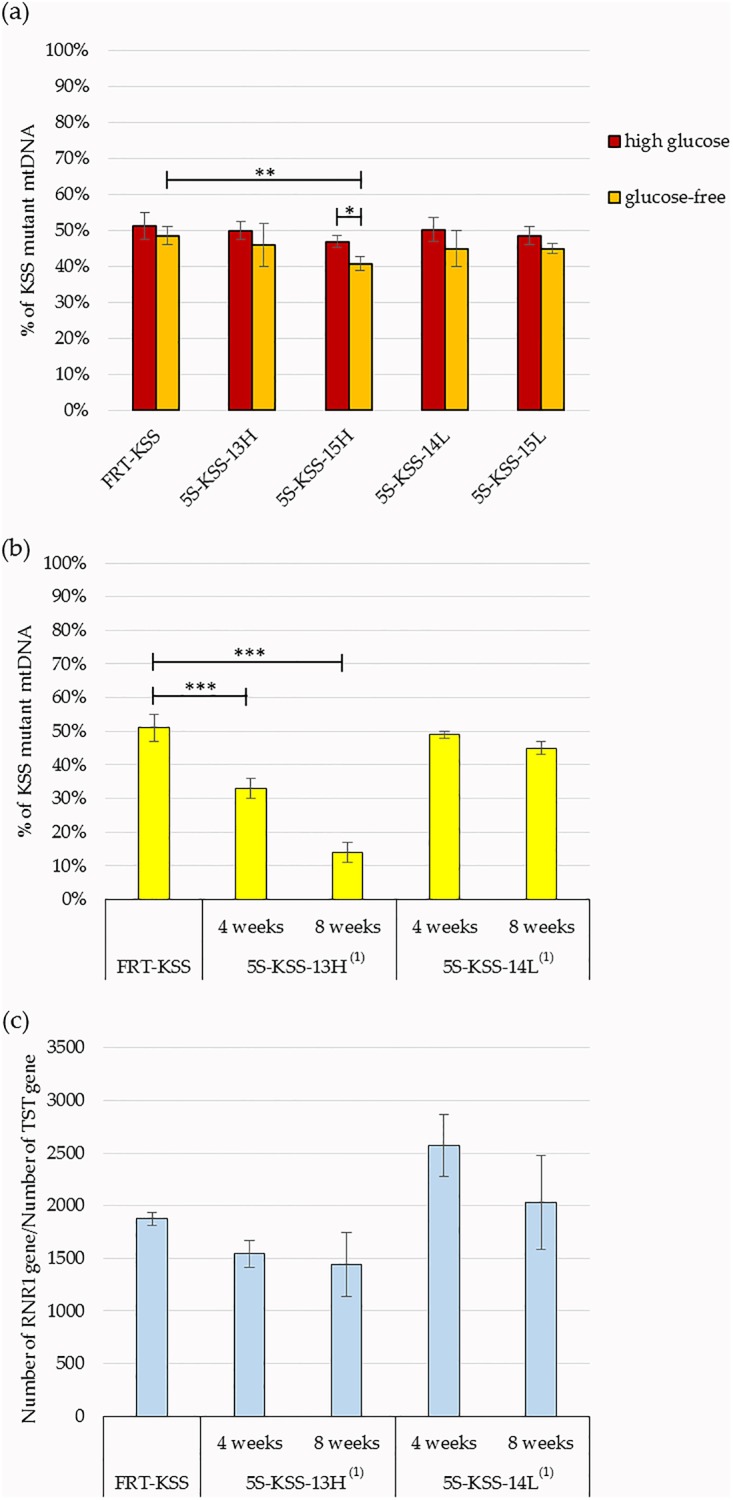
Effect of rec.5S rRNA expression on the heteroplasmy level of KSS mutation.(a) Proportion of KSS mtDNA (Y axis) in cybrids cell lines with low expression of rec.5S rRNA versions (see Table 1) after 8 weeks of cultivation in high glucose or glucose-free media, as indicated. (b) Time-depended decrease of KSS mutation load in cells expressing high amounts of rec.5S rRNAs 5S-KSS-13H(1) and 5S-KSS-14L(1) in glucose-free medium. (c) MtDNA copy numbers normalized to nuclear gene TST1, measured in the same cell populations as in (b). Cells issued from independent transfections were cultivated separately; each population was divided into 4 parallel cultures. Total DNA was isolated from a portion of each cell cultures every 2 weeks and analysed by 2–3 independent qPCR experiments, each measure performed in triplicates. Standard deviations are calculated from qPCR data obtained on the independently cultured cells (n = 4). Statistical differences were determined with a two-tailed Student’s t-test (*, p < 0.05; **, p < 0.01; ***, p < 0.001).